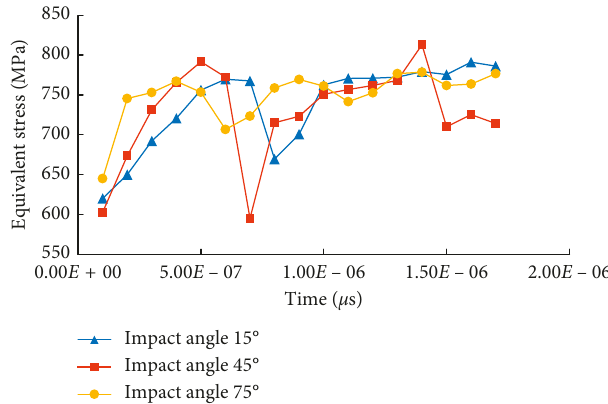
Figure 5: Equivalent stress changes at the erosion center with time.